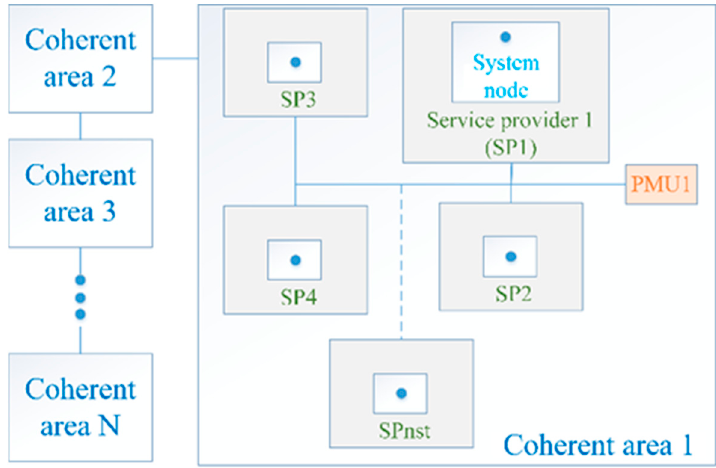
Figure 7. Overview of FFR control scheme and the diagram flow of the novel approach implementation. Each resource providing the FFR has one local controller and PMU device connected at the same or close connection point. The transmission network is divided into coherency zones (areas) that experience similar frequency behavior during disturbances (Figure 8).